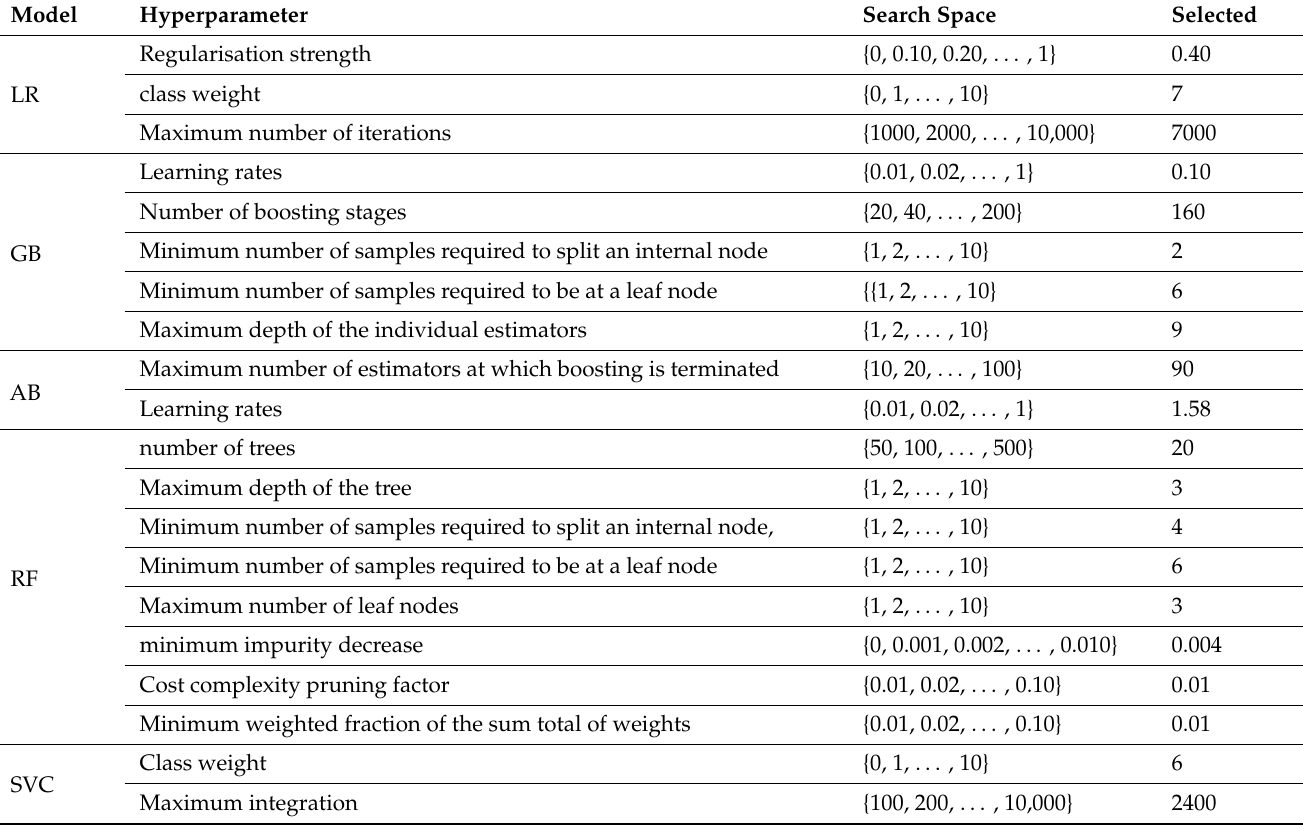
Table A1. The results of the conducted randomised hyperparameter tuning processes for the classi- fiers in the